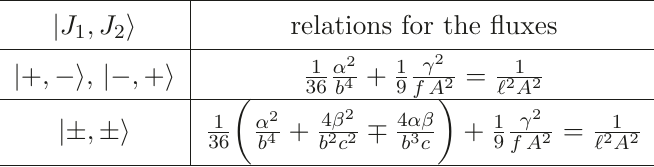
Table 8 . Decomposition of (3.94) into